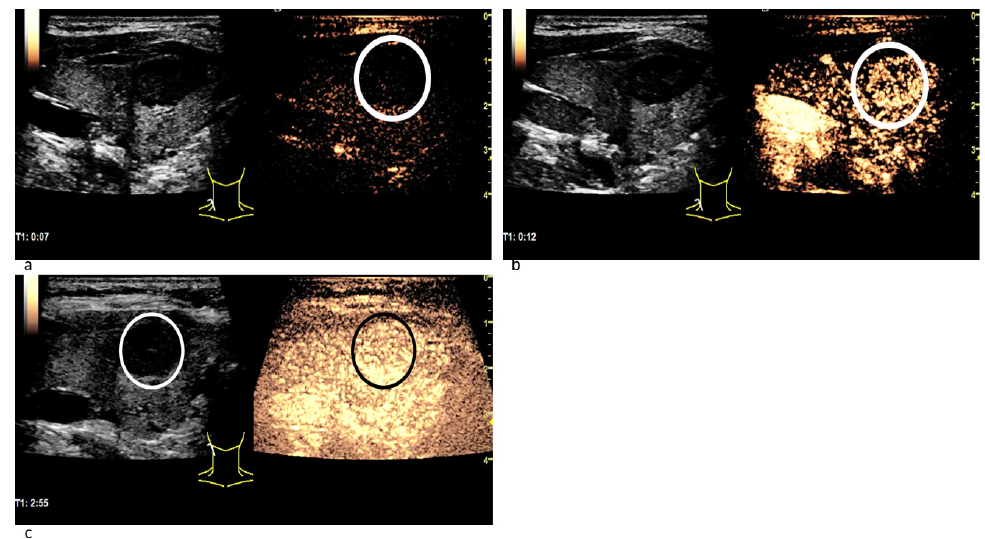
Figure 5. Patient with a benign thyroid nodule. The CEUS examination 7 s after the bolus injection ( a ) shows no contrast agent expansion in the nodule (white circle), yet. 12 s after the bolus injection ( b ) the contrast enhancement has begun: Microbubbles expand inside the lesion quite homogeneously (white circle) and not from the margins to the center. In the CEUS recording taken almost 3 min after bolus injection ( c ) the contrast agent intensity has not decreased: neither in the nodule (white circle in B-mode; black circle in CEUS) nor in the surrounding thyroid tissue. No wash-out phenomenon has occurred.